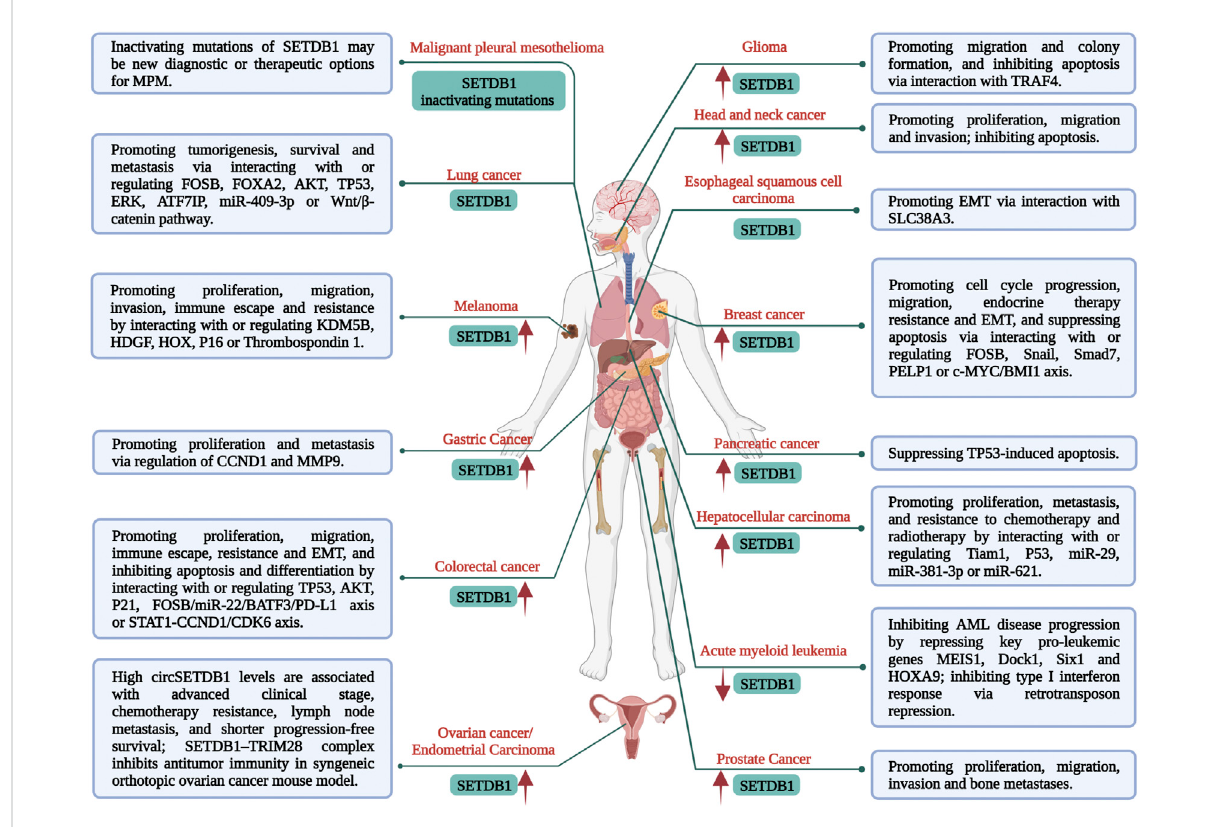
FIGURE 1 Multiple functions and mechanisms of SETDB1 regulation in